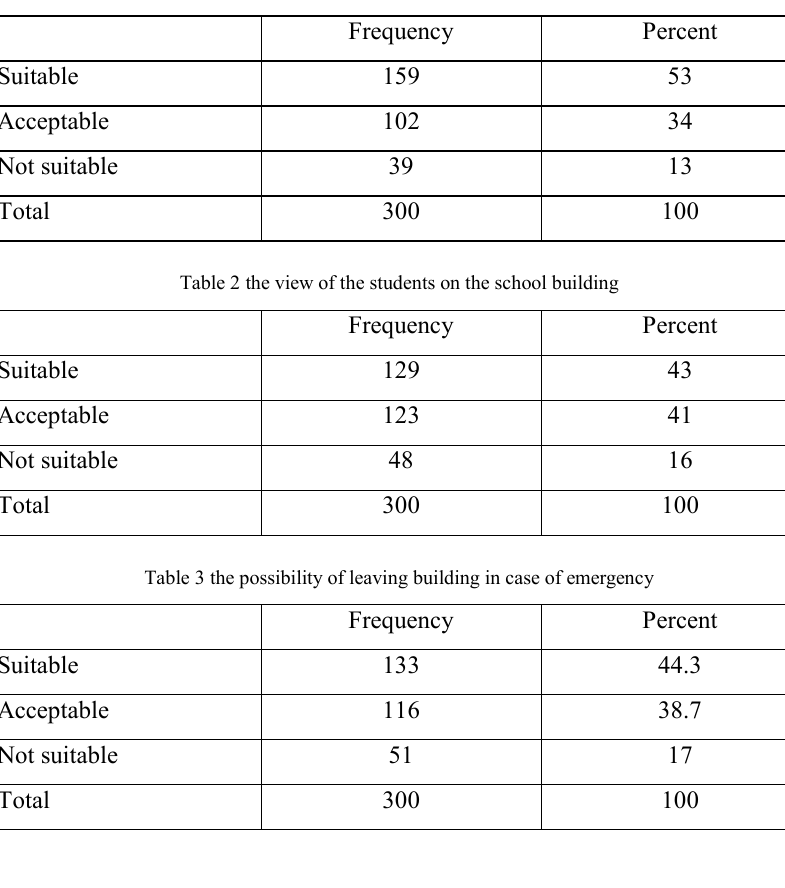
Table 1 distance between the school location and the living